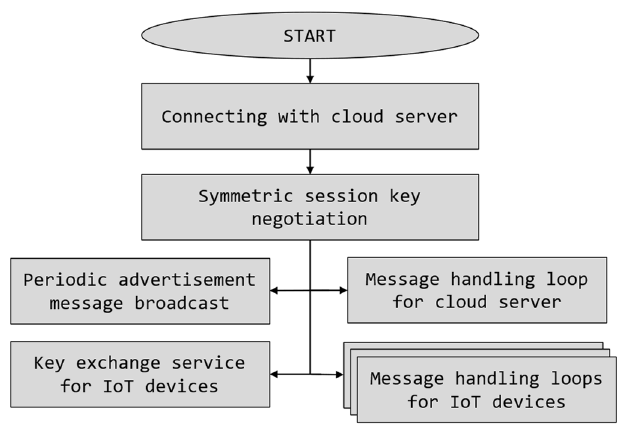
Figure 5. IoT gateway software operation in the IoT-Crypto